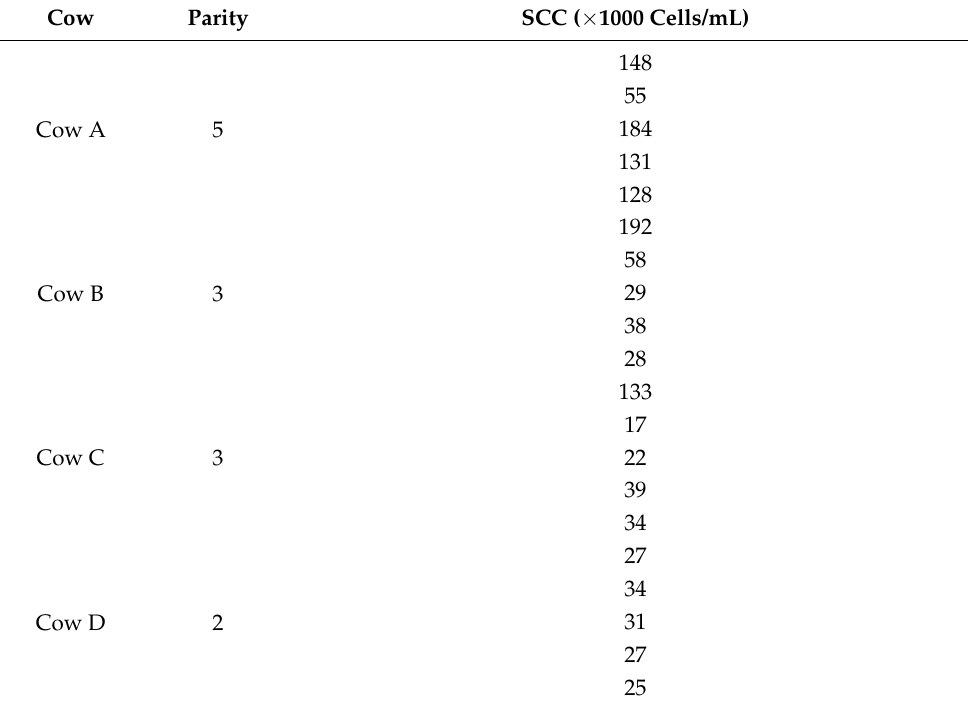
Table 1. Description of cows from Sample Set 1 (somatic cell count (SCC), and parity). Cow Parity SCC ( × 1000 Cells/mL) Cow A 5